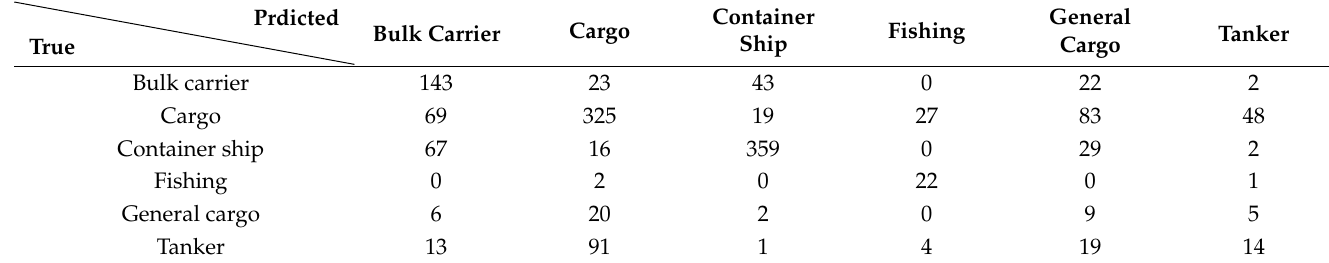
Table 6. Confusion Matrix of the Six-Category Task.